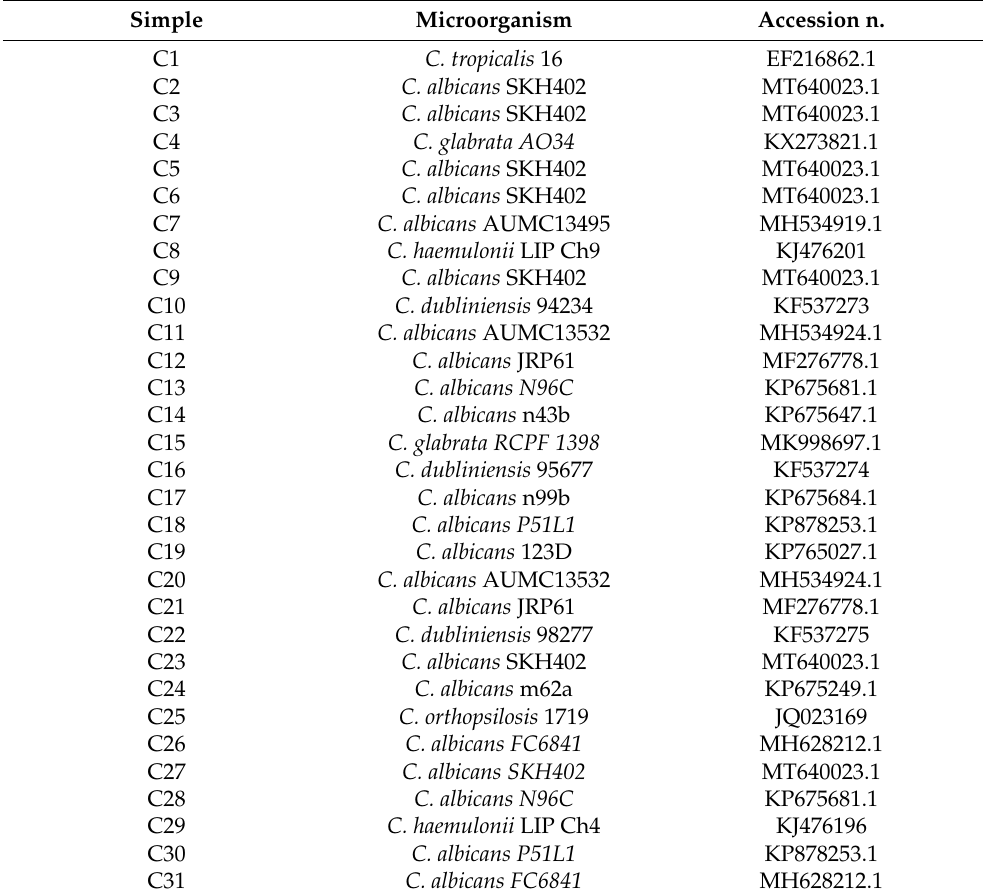
Table 2. Molecular characterization, following Sanger sequencing, of Candida spp. strains isolated from vaginal specimens.